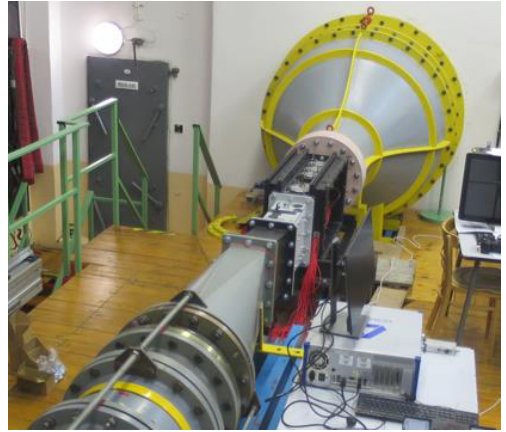
Figure 1. Test section mounted in the wind